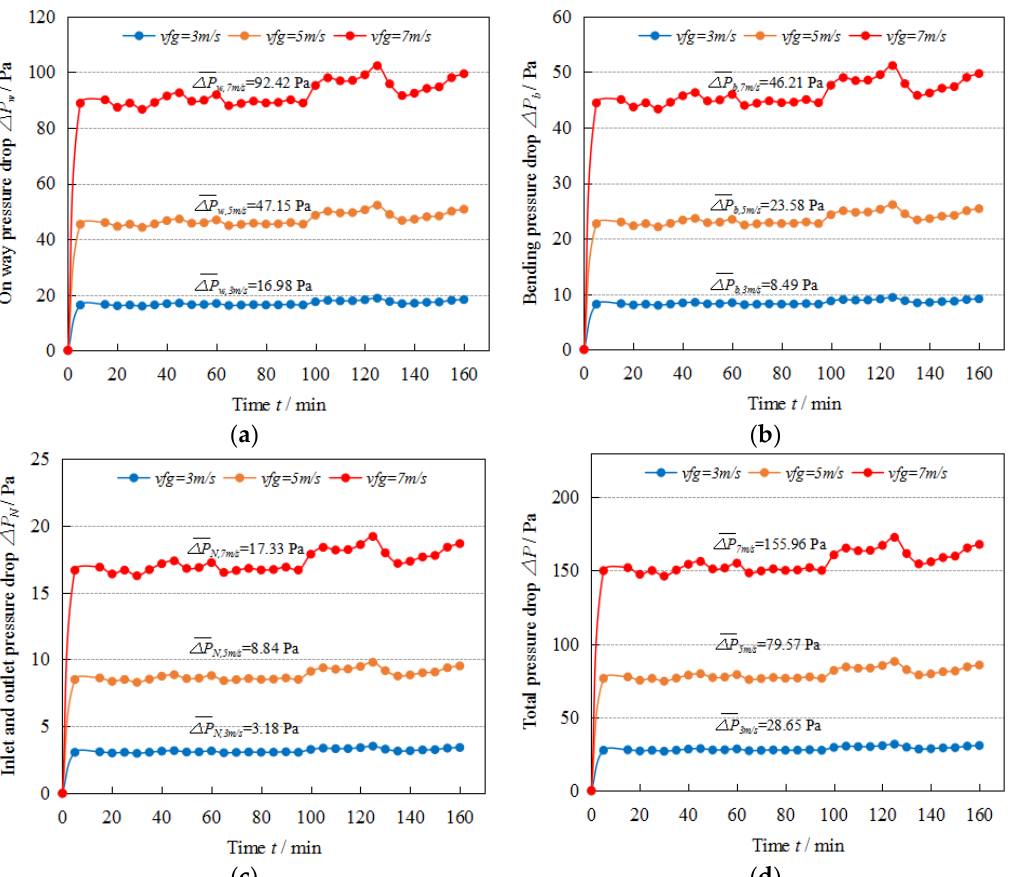
( c ) ( d ) Figure 8. The variations of Figure 8. The variations of ∆ p w ( a ), ∆ p b ( b ), ∆ p n ( c ) and ∆ p ( d ) under different inlet v fg values over t values over t .